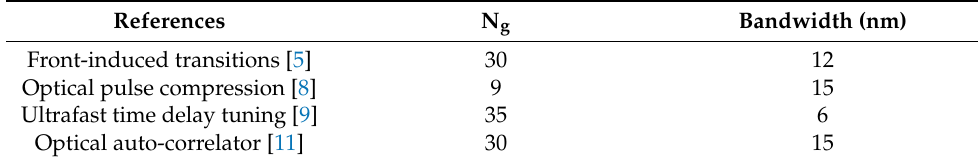
Table 1. Typical Dispersion Engineering PhCW Used in the Ultrafast Integrated